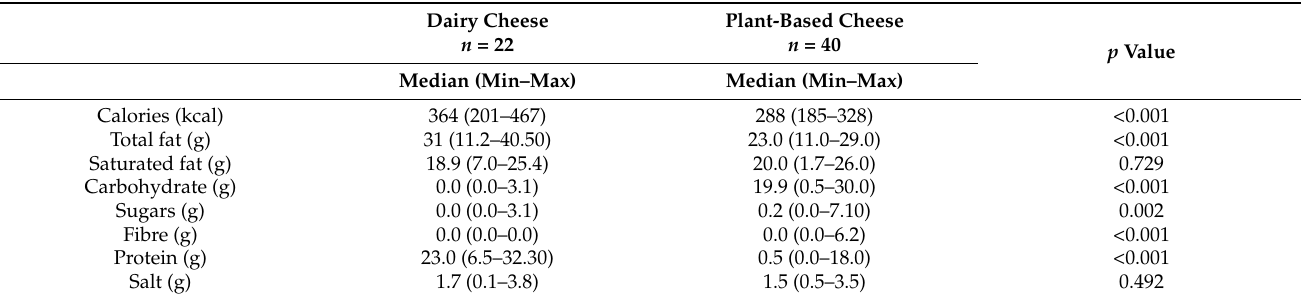
Table 2. Median (minimum–maximum) values of calories and nutritional content in dairy cheese and plant-based cheese alternatives per 100